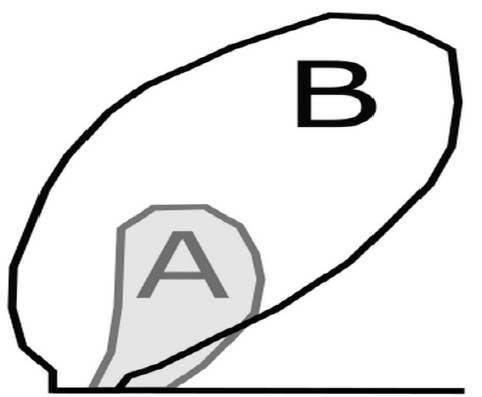
12 of 14 Figure 12 . Relationship between the SIF opening values and the level of in-plane constraints. 8. Conclusions In the paper, the numerical model of a crack subjected to cyclic loading was applied. The obtained results, to some extent, were compared with the analytical solution. Satisfac- tory convergence of the results with theoretical formulae suggested that the model pre-